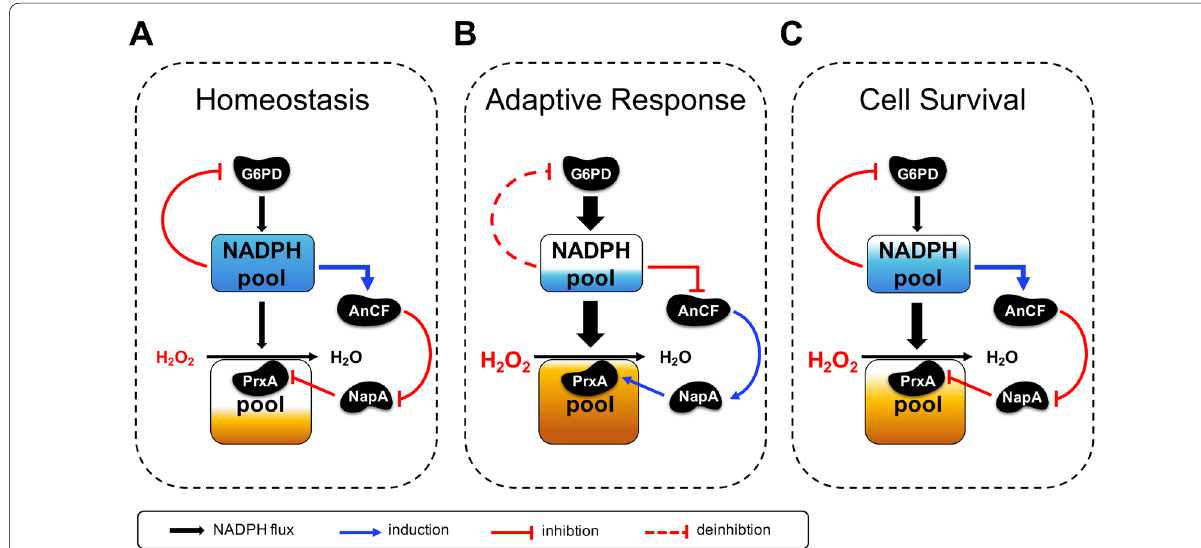
Fig. 6 Schematic illustration of NADPH-mediated autoregulation mechanism for adaptation to oxidative stress in A. nidulans . A – C Under normal conditions ( A , Homeostasis stage) the NADPH pool provides an adequate supply of NADPH to reduce AnCF to its activated state, which will suppress NapA and subsequently lower the levels of PrxA. Due to the absence of high consumption of NADPH, the intracellular NADPH pool is maintained at a high level causing G6PD activity inhibition. Thus, the inflow of NADPH from G6PD to the NADPH pool is quite limited. Once fungi encounter H 2 O 2 ( B , Adaptive response stage), NADPH is suddenly needed to decompose H 2 O 2 using PrxA, leading to an immediate drop within 30 min. Inevitably, the inflow of NADPH from the NADPH pool to reduce AnCF is declined. The accumulation of oxidized AnCF activates napA to supply more PrxA until the PrxA pool is saturated, accelerating NADPH consumption while resisting H 2 O 2 . Next, the depletion of NADPH reactivates G6PD, and NADPH eventually reaches to the initial level in the next 30 min ( C , Cell survival stage). The increased NADPH level triggers the reactivation of AnCF, which consequently shuts down NapA induction, represses NapA activity via NADPH-dependent reduction to block PrxA induction, and ultimately keeps the PrxA pool at a moderate level ( C , Cell survival